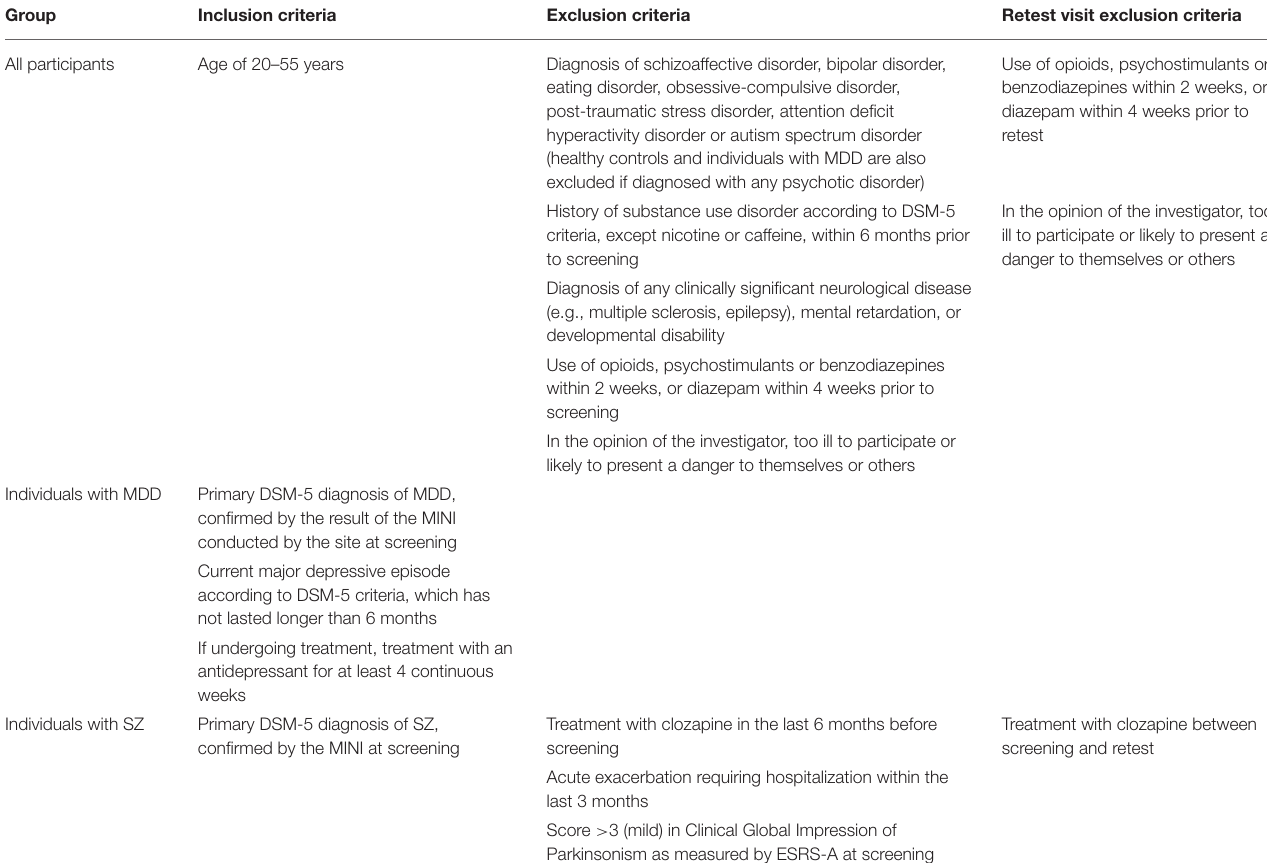
TABLE 1 | Eligibility criteria.